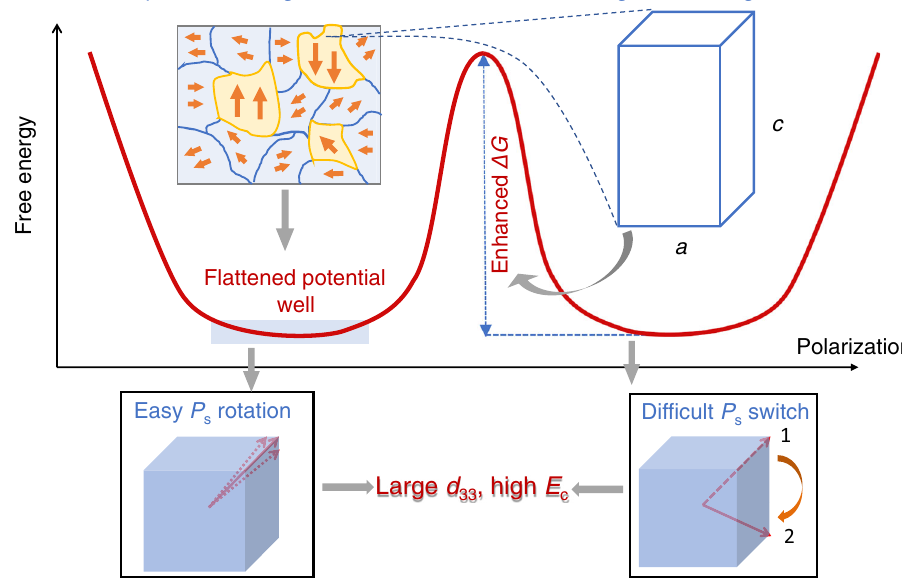
Fig. 5 Simultaneous achievement of ultrahigh piezoelectricity and extremely large E C . The particular local structure and relatively large c/a ratio in the PSN – PMN – PT are used to manipulate the free energy pro fi le in different ways, affording a “ deep and fl at ” free energy landscape. The PSN – PMN – PT system exhibits various characteristics including high level of local structure heterogeneity, slush-like multiphase coexistence, small domain size, and high density of PNRs, accounting for a fl at potential well. Moreover, the lattice of PSN – PMN – PT system contains a considerable tetragonal phase component, demonstrating large anisotropy, which consequently contributes to a deep well, namely an enhanced Δ G . The fl attened potential well facilitates the polarization ( P S ) rotation/elongation around the equilibrium position, enhancing the piezoelectric response, and the enhanced energy barrier makes the P S switch more dif fi cult, contributing to a large E C